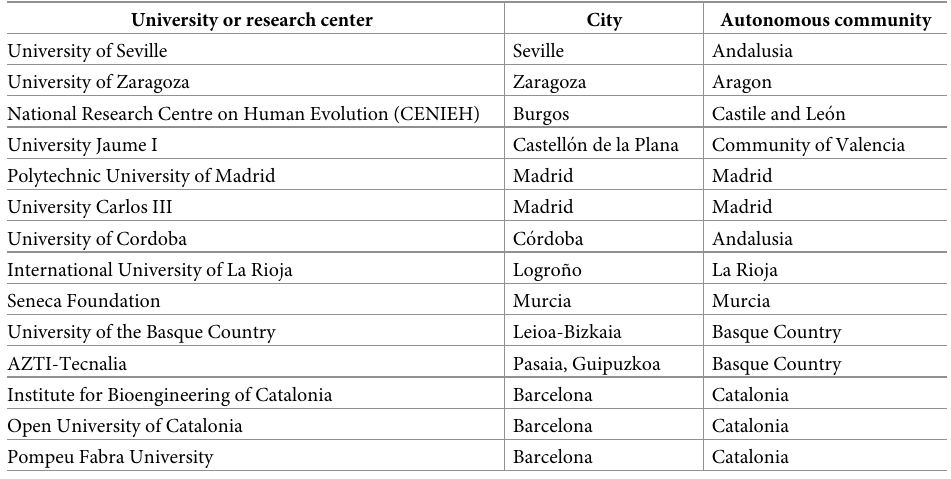
Table 1. Working group